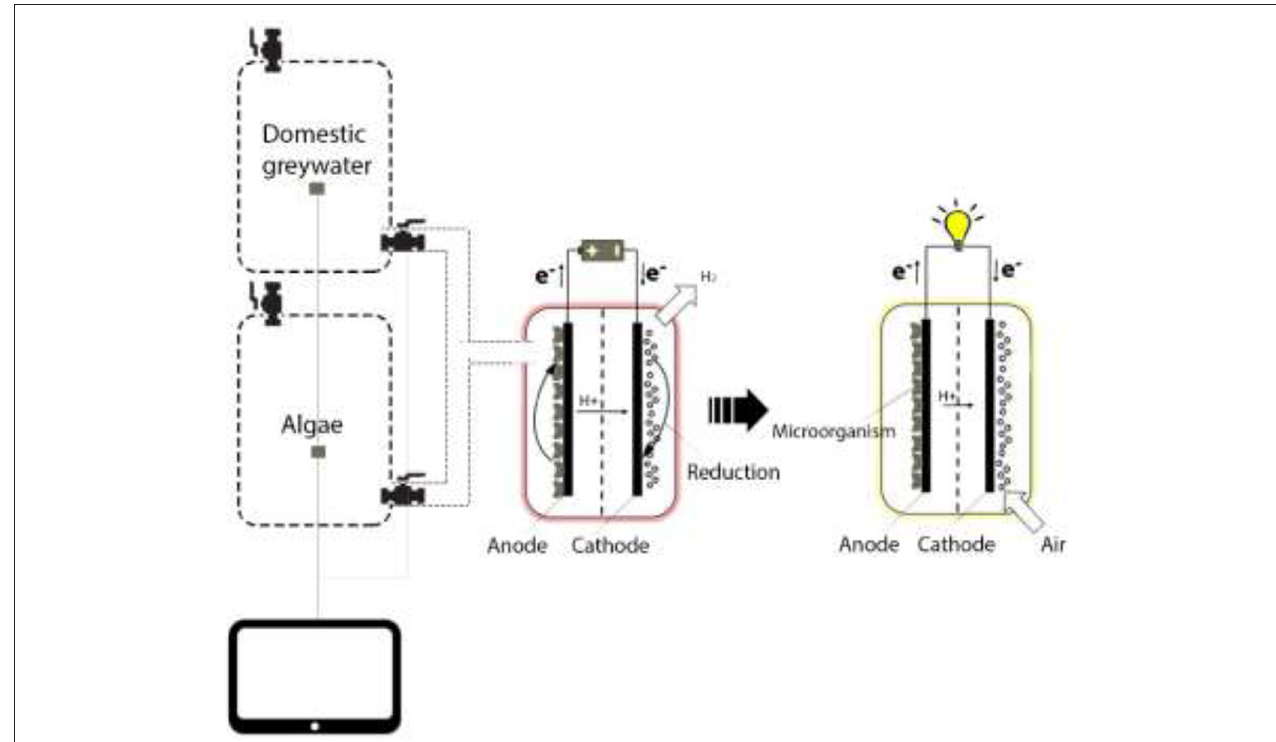
FIGURE 5 | Project overview.